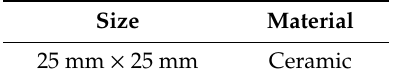
Figure 22. Device efficiency of different number of modules. Table 3. Best option parameters for the TEG